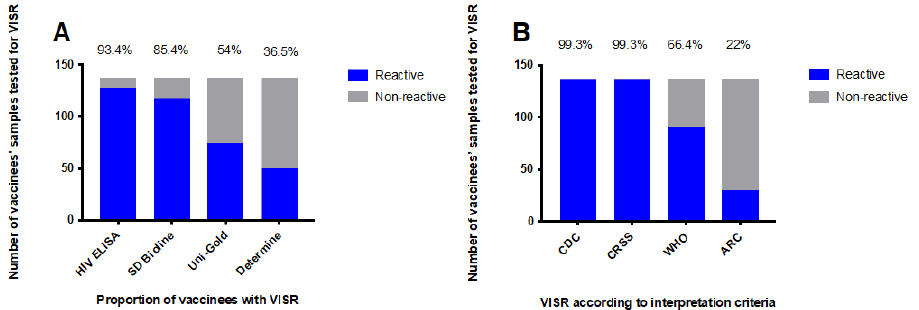
Figure 1. Frequency of VISR. Samples collected four weeks after the final vaccination were evaluated for VISR using rapid point-of-care tests and ELISA ( A ). The highest rates of VISR were seen when using Enzygnost HIV Integral 4 ELISA and SD Bioline HIV-1/2 3.0. HIV misdiagnosis according to western blot interpretation criteria ( B ). The VISR results were interpreted using the criteria detailed in Table 1 (CDC, CRSS, WHO, and ARC criteria). The majority of the vaccinees would have been misclassified as HIV-infected using the CDC and CRSS interpretation criteria.